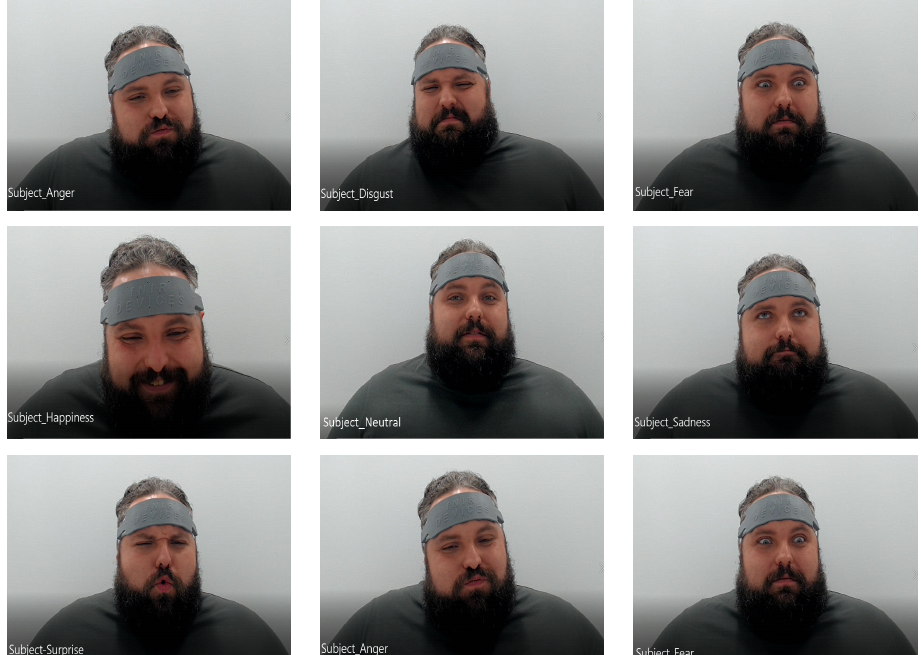
Figure 4. An array of representative facial expressions of a participant’s seven emotions: Anger, Disgust, Fear, Happiness, Sadness, Surprise, and Neutral. The participant gave his consent to share his